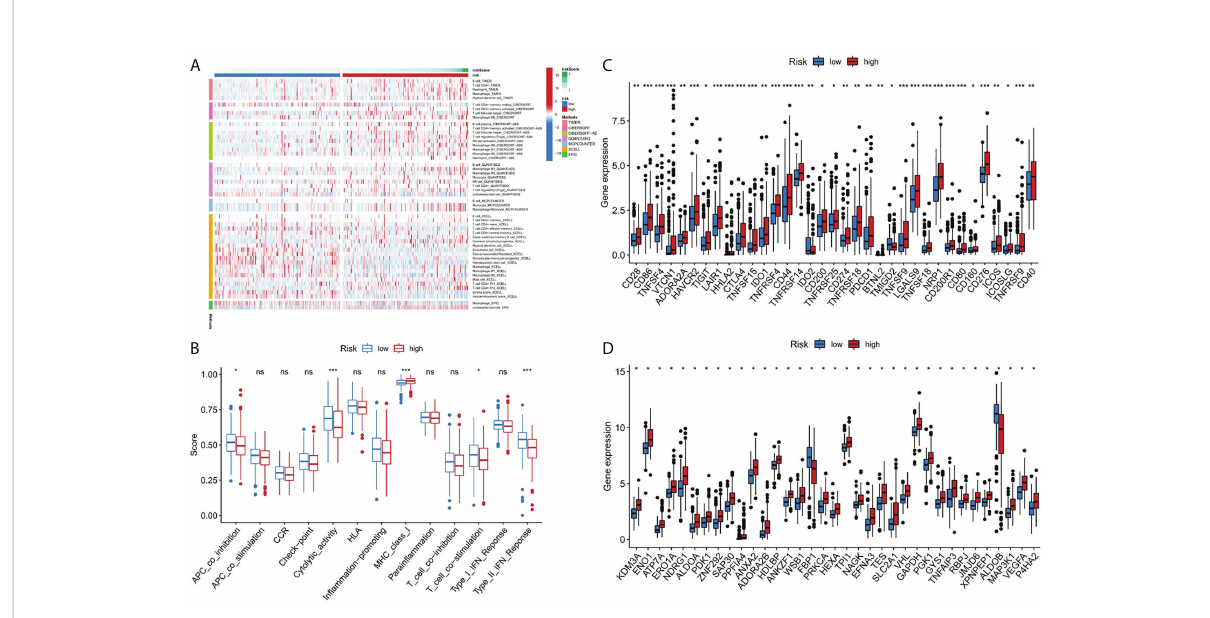
FIGURE 5 Immune-related functional analysis. (A) The landscape of immune in fi ltration in two risk groups for liver cancer patients. (B) Boxplot visualizing differentially immune functions. “ ns ” stands for not signi fi cant. (C) Comparisons of immune checkpoints between the two risk groups in liver cancer patients. *p < 0.05; **p < 0.01; ***p < 0.001. (D) Comparison of the expression of hypoxia-associated genes between the two risk groups in liver cancer patients. *p < 0.001. ns, not signi fi